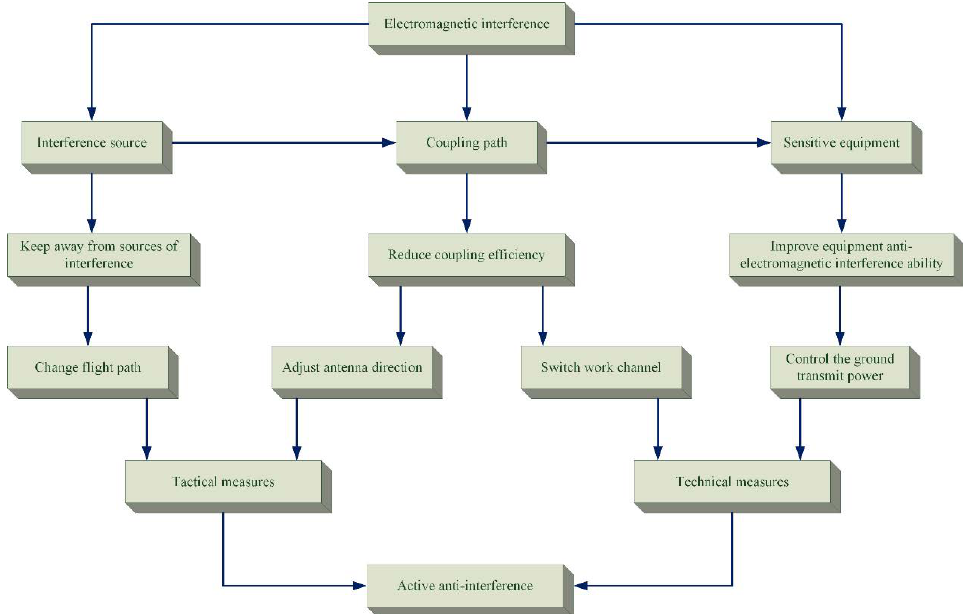
Figure 5. UAV data link electromagnetic interference adaptive